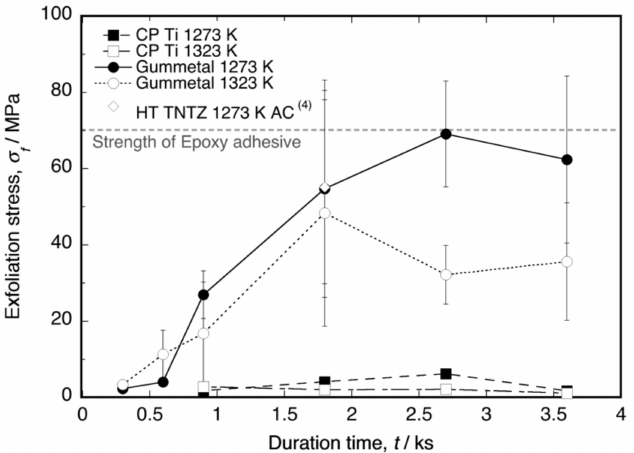
Figure 2. Exfoliation stress of oxidized CP Ti, Ti–36Nb–2Ta–3Zr–0.3O (Gummetal), and Ti–29Nb– 13Ta–4.6Zr (TNTZ cooled in air after oxidation, data from [4]) as a function of the time duration at 1273 K and 1323 K. The error bar indicates standard deviation.